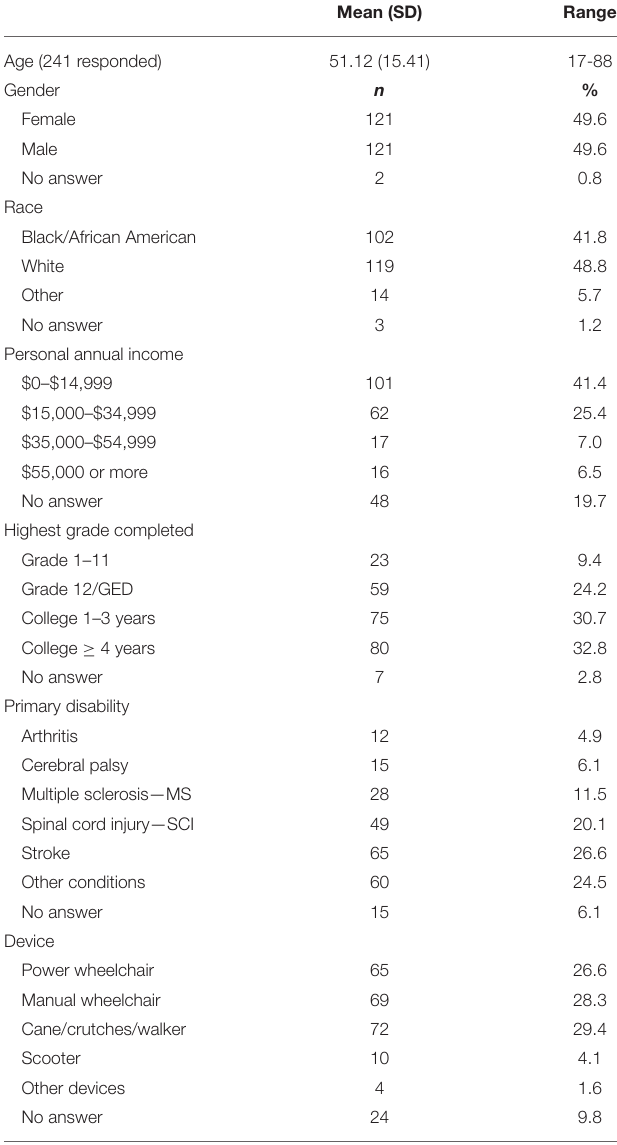
TABLE 2 | Demography of intervention sample ( N =